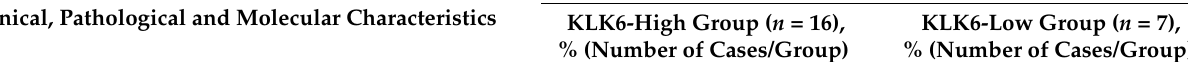
Table 1. Clinical and molecular analysis of the KLK6-high and KLK6-low groups in TCGA colon adenocarcinoma dataset.